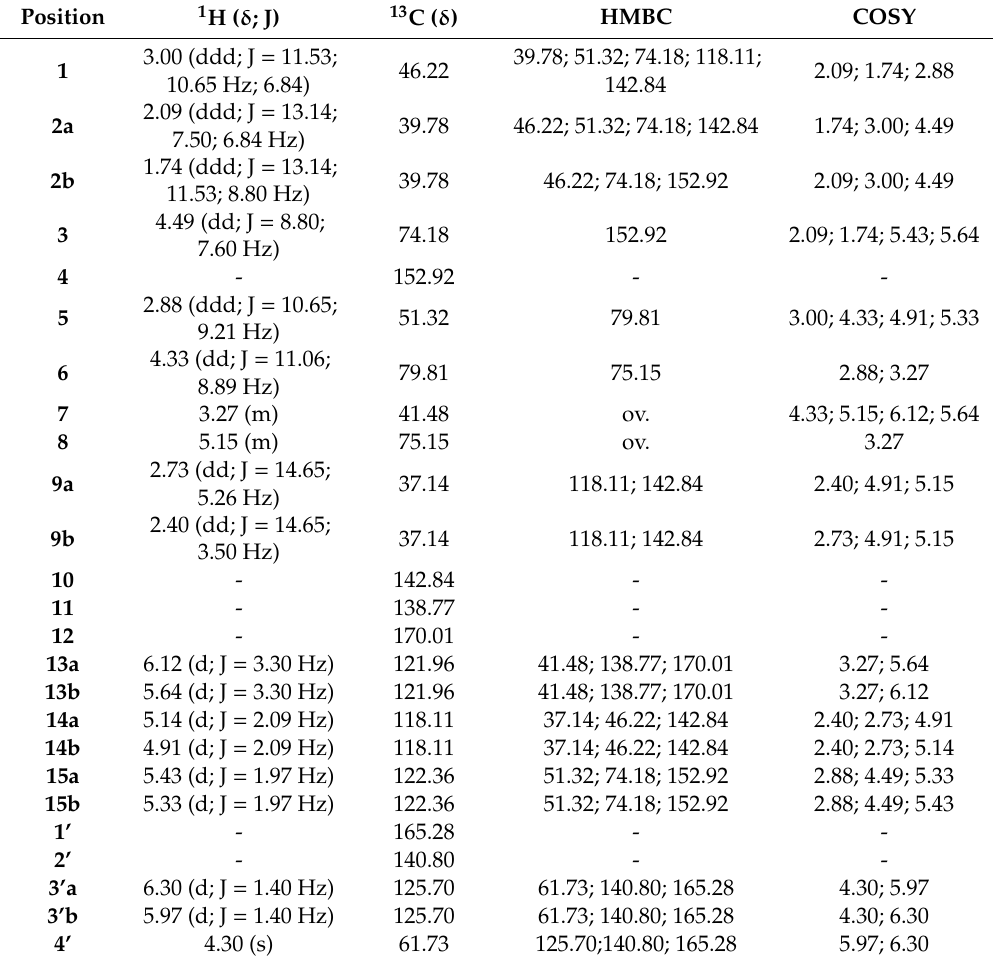
Table A1. NMR spectral references for cynaropicrin. Spectra of the purified fraction were measured in CD 3 OD. Splitting patterns and coupling constants were determined by J-res